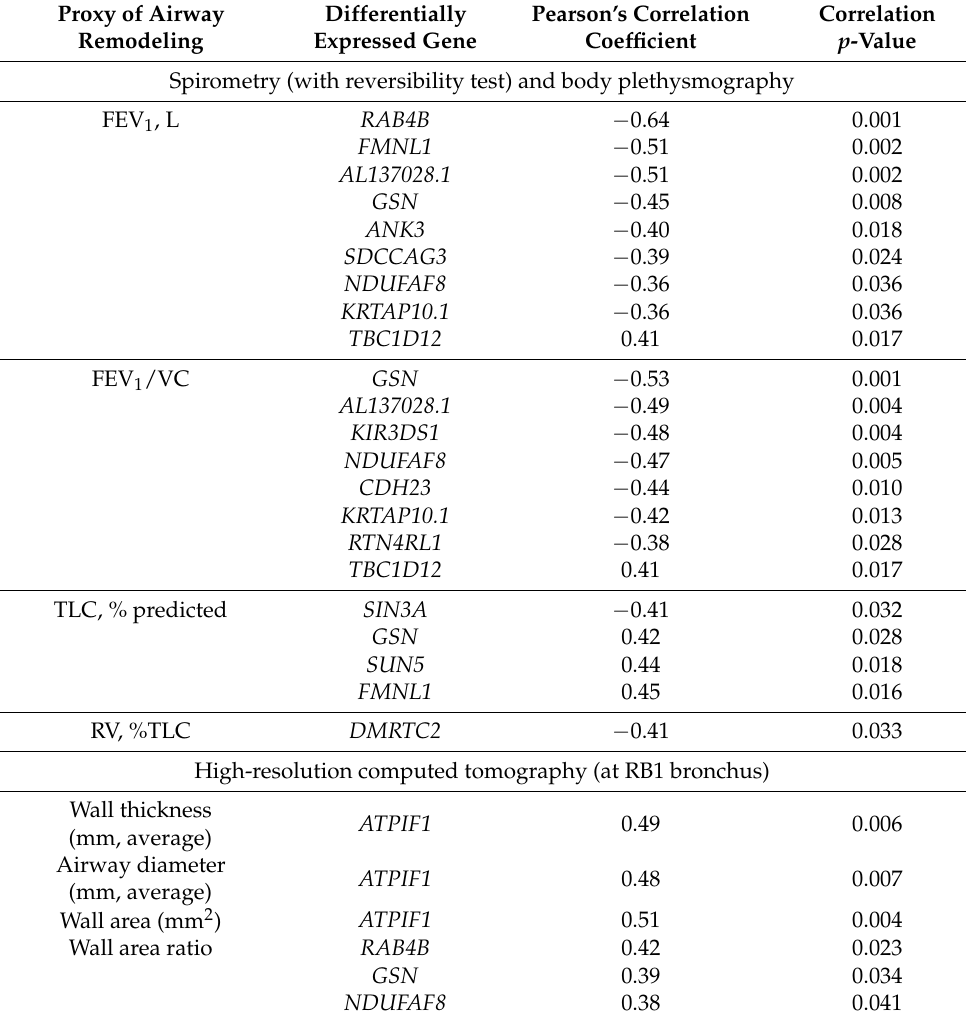
Table 5. Correlations between expression levels of the differentially expressed genes, lung function parameters, and high-resolution computed tomography proxies of airway remodeling. Proxy of Airway Differentially Pearson’s Correlation Correlation p -Value Remodeling Expressed Gene Coefficient Spirometry (with reversibility test) and body plethysmography FEV 1 , L RAB4B − 0.64 0.001 FMNL1 − 0.51 0.002 AL137028.1 − 0.51 0.002 GSN − 0.45 ANK3 −